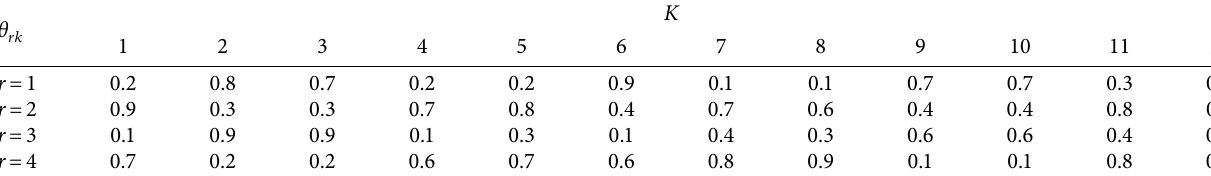
Table 3: Parameter specifcation of Model